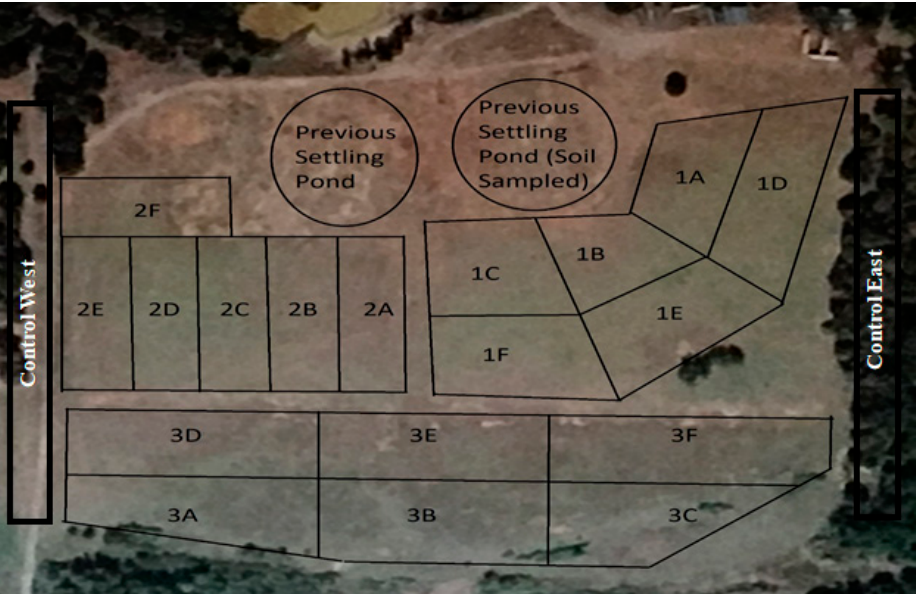
Figure 1. Map of the land-farm site showing three fields sampled, control areas, and settling pond. Letters indicate subunits sampled in each